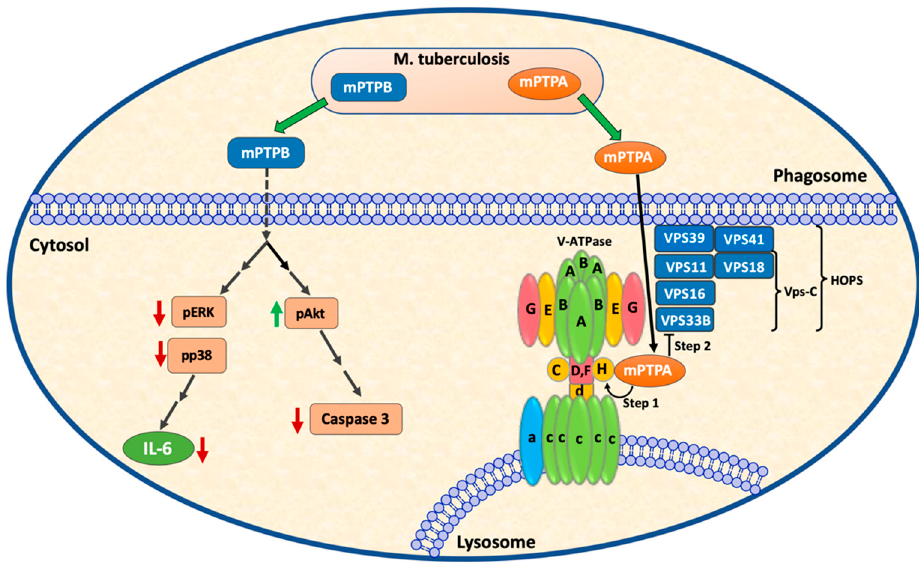
Figure 2. Roles of mPTPA and mPTPB in mediating pathogen − host interactions. mPTPA and mPTPB are secreted by Mtb during macrophage infection (shown by green arrows). mPTPA has been demonstrated to translocate to the macrophage cytosol. mPTPA binds to subunit H of V ‐ ATPase (Step 1) to selectively localize to its catalytic substrate VPS33B at the phagosome–lysosome fusion interface. Dephosphorylation of VPS33B (Step 2) results in the exclusion of V ‐ ATPase from